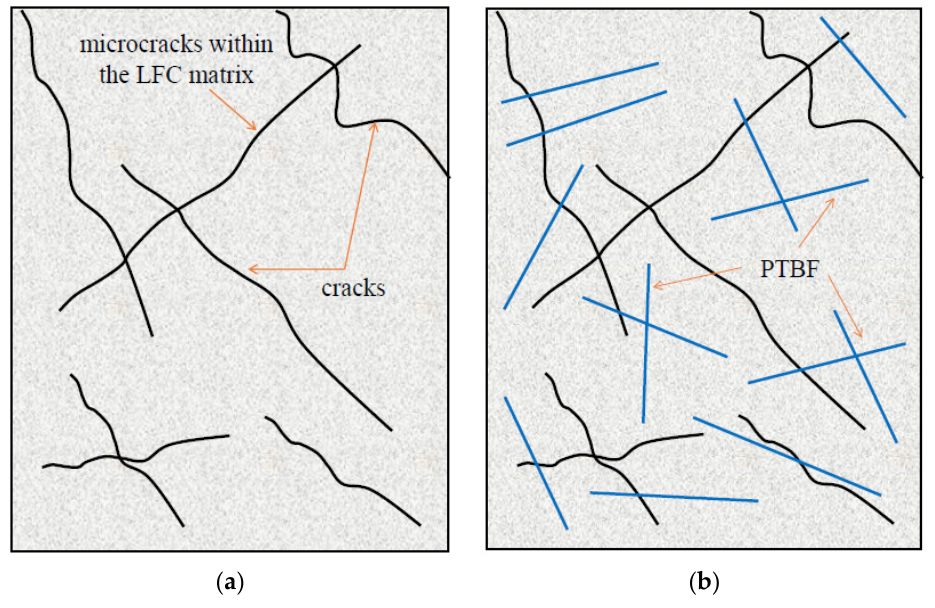
Figure 27. Schematic diagram of PTBF impeding LFC cracks ( a ) cracks and microcracks occur within the LFC cementitious matrix. ( b ) PTBF restricted the propagation of cracks and microcracks.